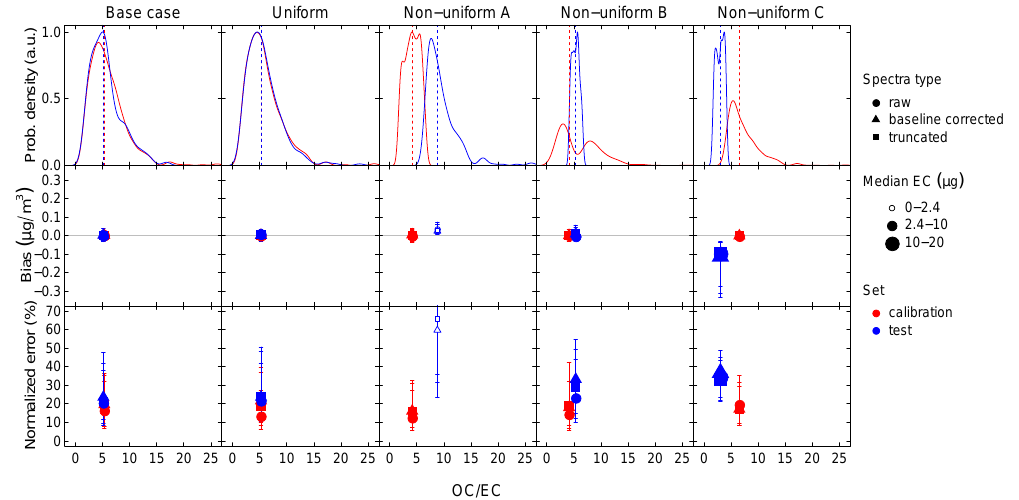
Figure 4. The probability distribution of OC/EC and bias and normalized error (with the interquartile range shown by error bars) in the calibration (red) and test (blue) sets for five hybrid calibration cases: the Base case, the Uniform OC/EC case and three Nonuniform OC/EC cases. Vertical lines on the probability distributions are the color-coded median of the OC/EC